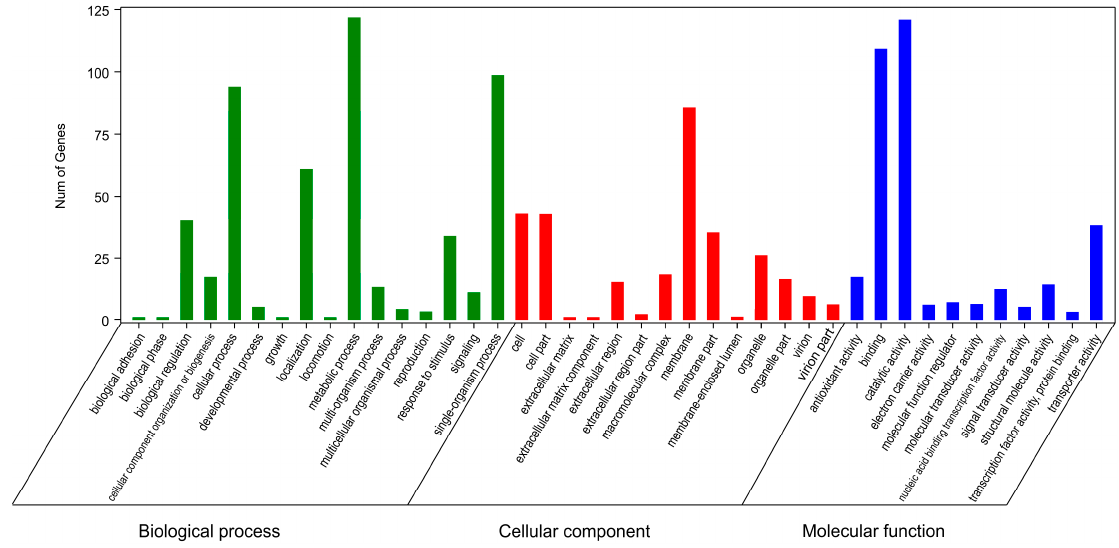
Figure 6. Gene ontology analysis revealed significant enrichment of the 291 common differentially expressed genes in certain categories.